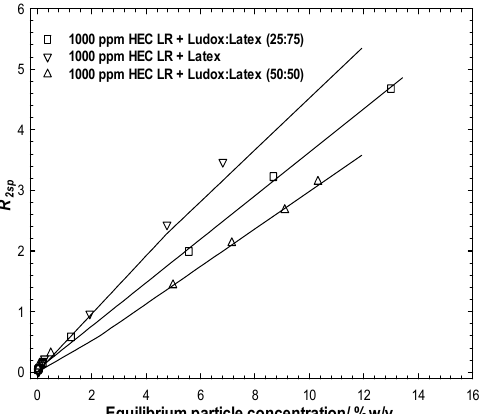
Figure 5. Calculated relaxation rate data for the Ludox/latex particle mixtures presented in Figure 2 i.e., initial particle weight fraction of 10 wt% post-centrifugation and exposure to 1000 ppm HEC LR assuming a 25% greater probability of adsorbing to the Ludox surface up to a degree commensurate with the single particle limit.